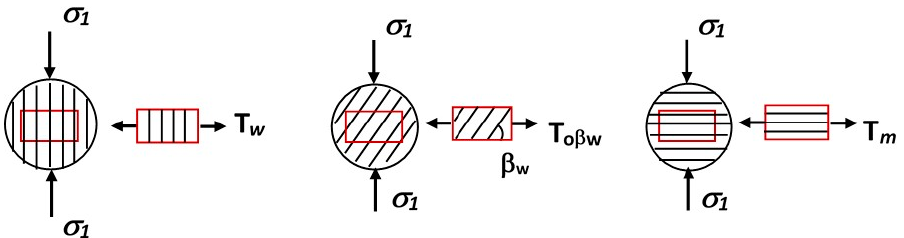
Figure 3. Definition of the “tensile strengths” of the Nova and Zaninetti criterion for a Brazilian test.